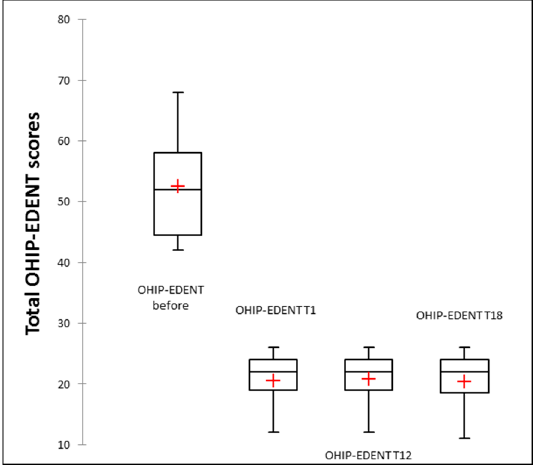
Figure 14. Boxplots for the changes in OHIP-EDENT overall scores.